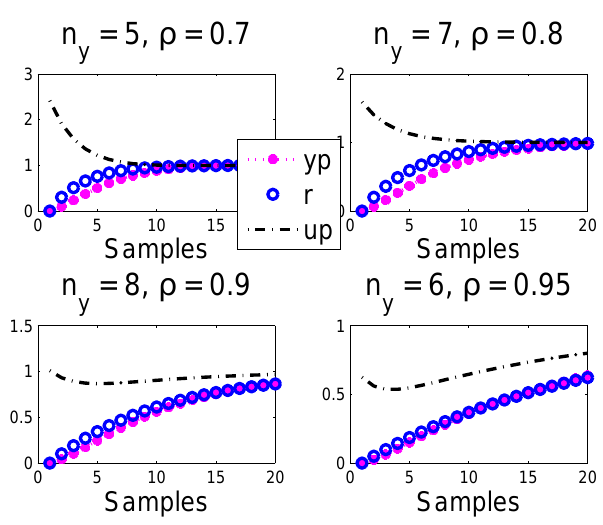
Figure 10. Closed-loop step responses for a second order system G overlaid with the underlying target trajectory.